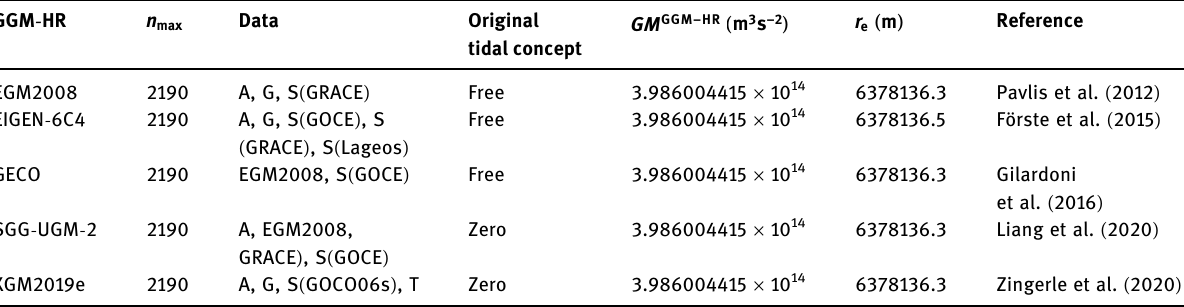
Table 1: GGMs - HR used for the evaluation tests at the 2287 GPS/levelling benchmarks GGM -